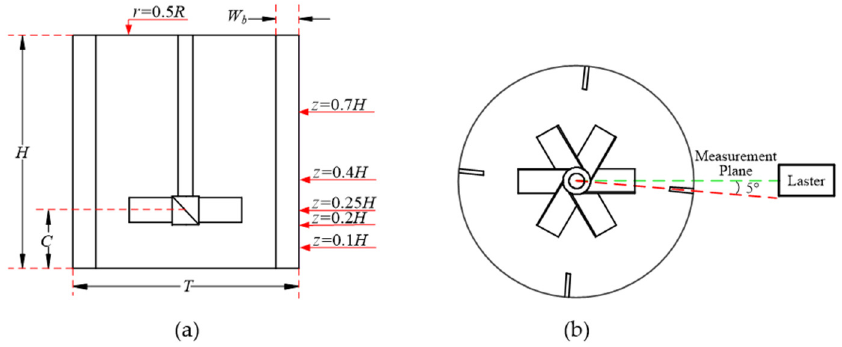
Figure 4. Schematic of the investigated stirred tank. ( a ) Vertical view along the axis and CFD monitoring position, ( b ) horizontal (top) view and experimental measurement plane. Table 2. The physical properties of the fluid and particle.